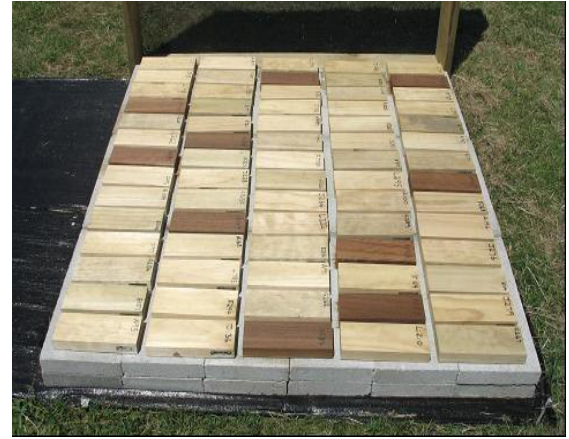
Figure 1. Ground proximity test at installation with the shade-cloth and frame removed. The samples are placed on two layers of 40 mm thick pumice slabs with plastic weed mat underneath.